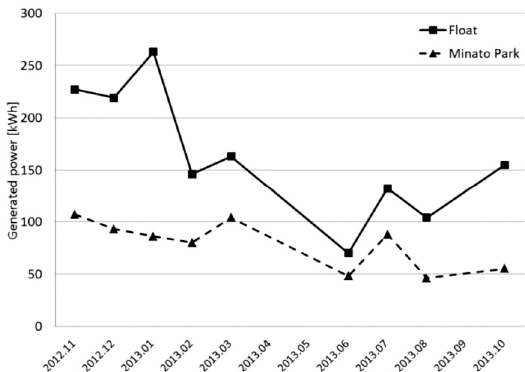
Fig. 8. Monthly power output comparison between the offshore platform and Minato Park.